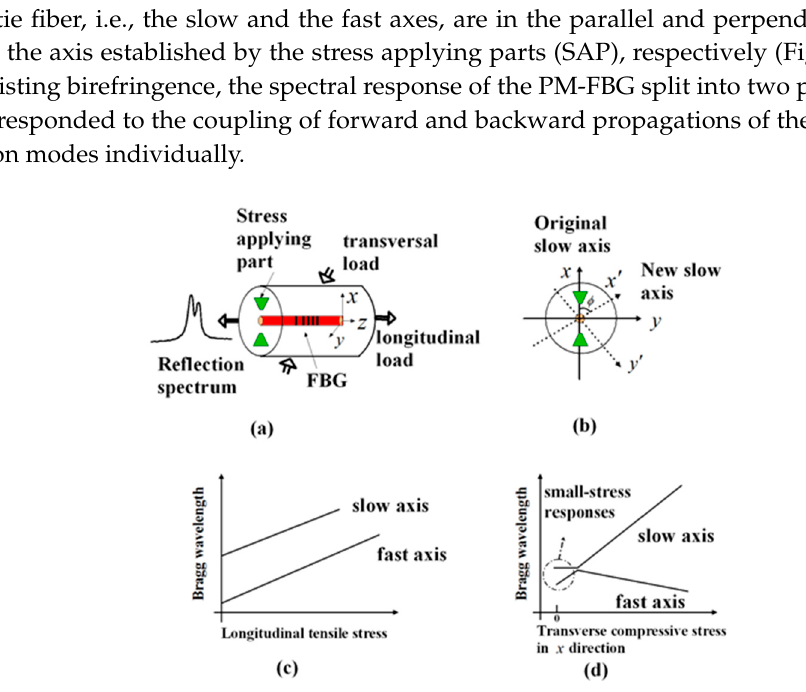
Figure 2. ( a ) Schematic of a Polarization-maintaining Fiber Bragg grating and its spectrum, ( b ) rotation of principal axes under transversal stresses, ( c ) responses of the Bragg wavelength to the longitudinal tensile stress [41] and ( d ) variation of Bragg wavelength originating from the change of effective index of reflection with applied x direction load [40].